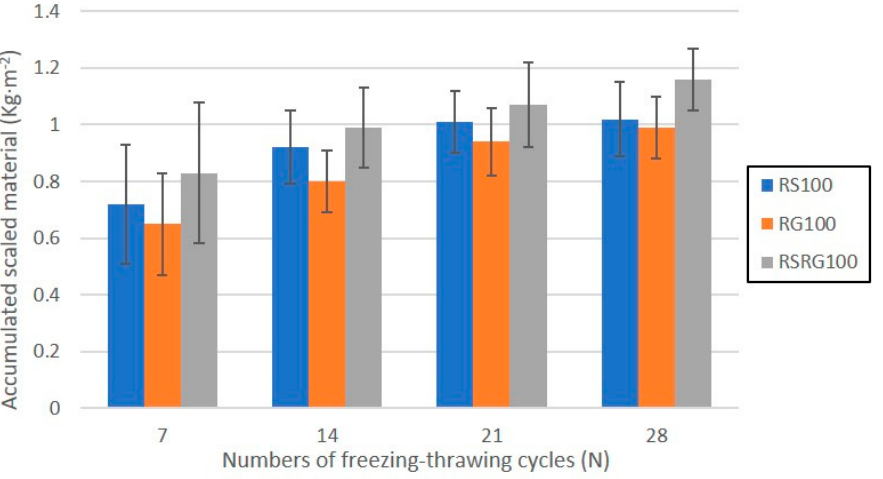
Figure 9. Graphical representation of the accumulated scaled material vs. numbers of freezing– thrawing cycles. thrawing